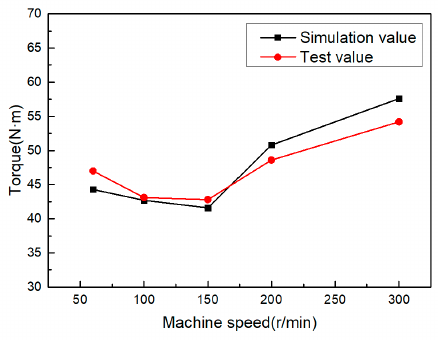
Figure 9. The e ff ect of machine speed on Figure 9. The effect of machine speed on torque.